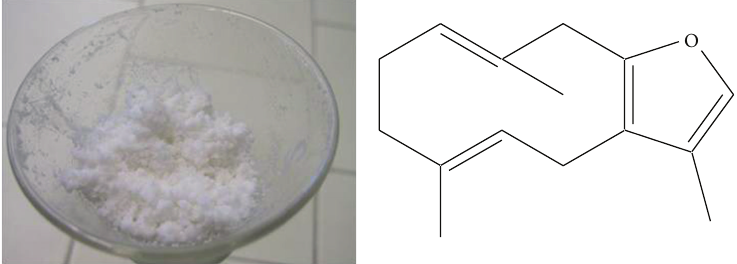
Figure 1: Crystals and chemical structure of isofuranodiene.